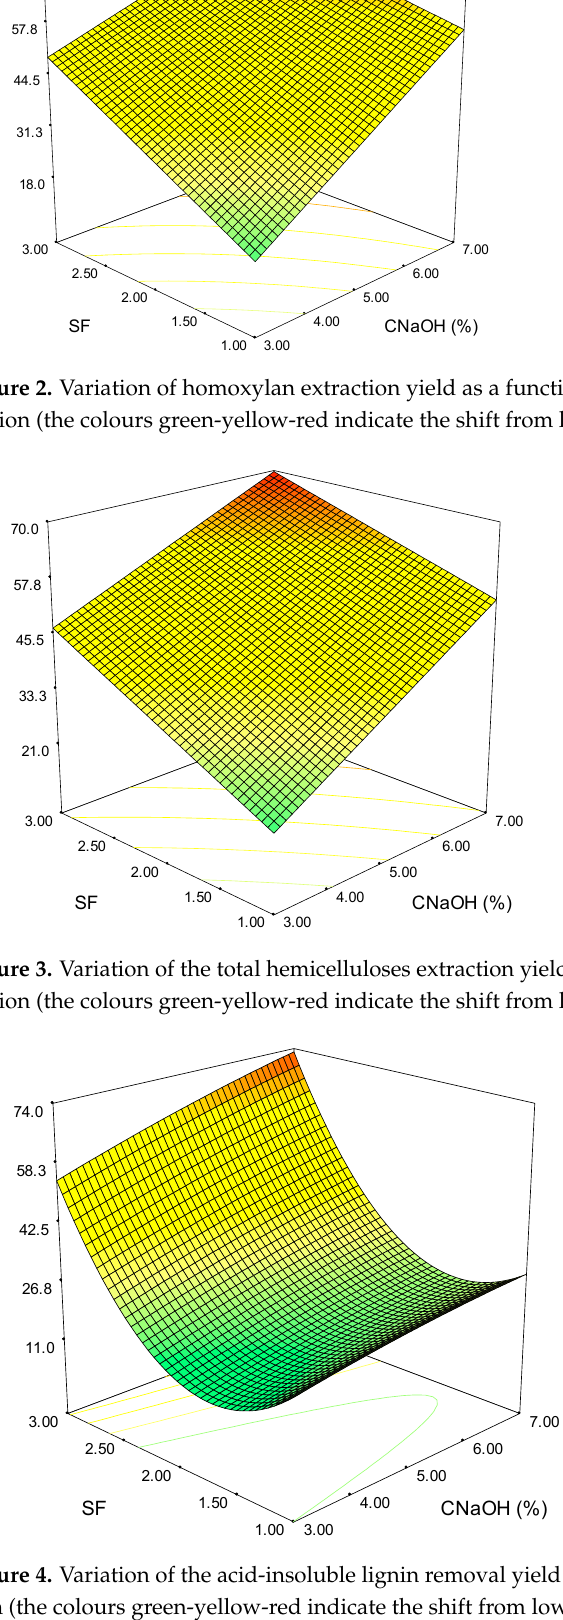
tration (the colours green-yellow-red indicate the shift from low to high values).